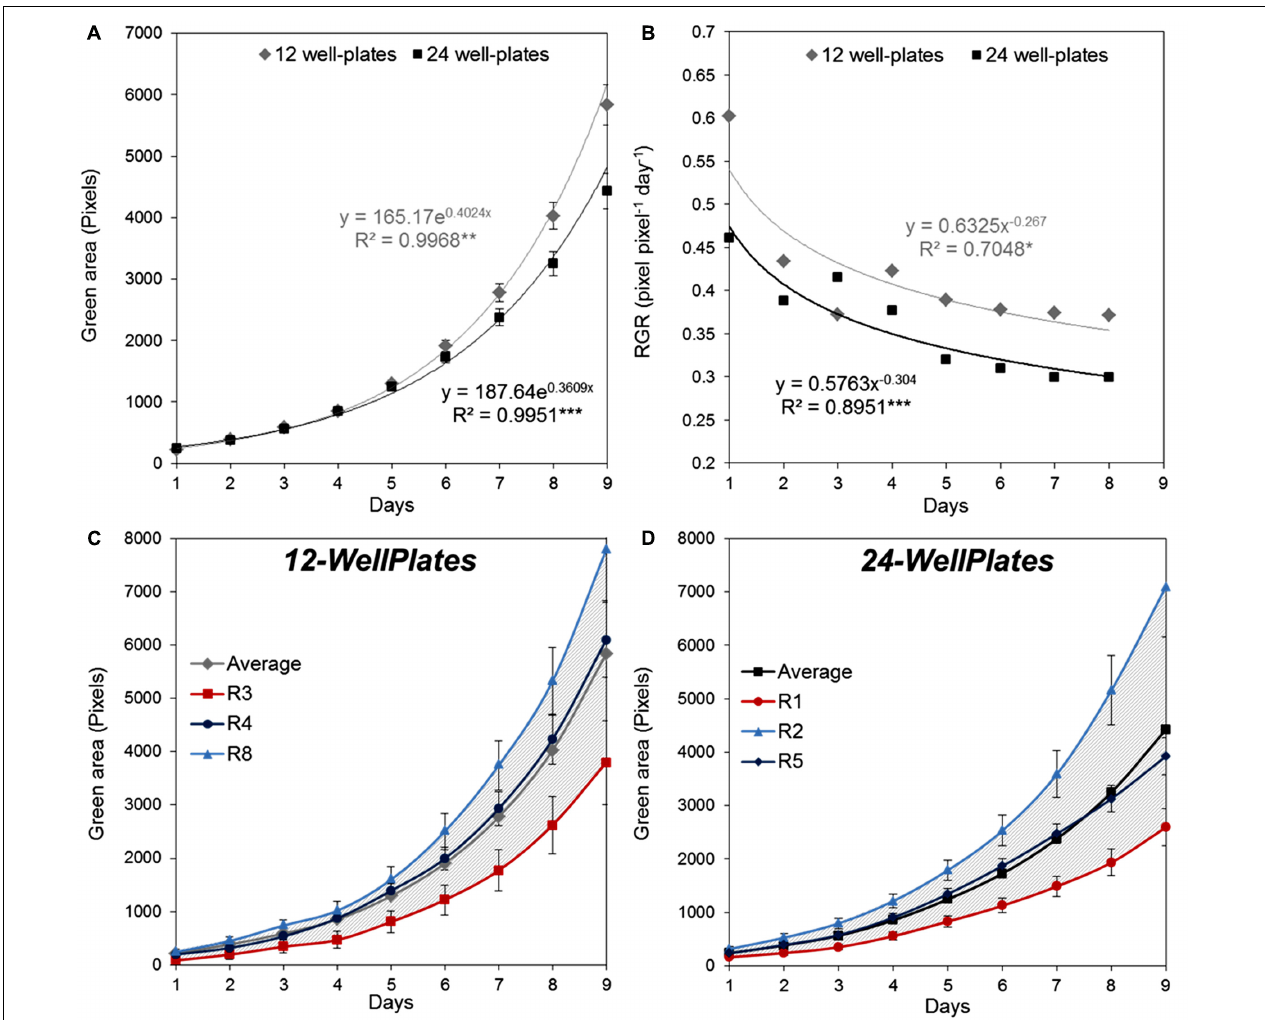
FIGURE 3 | Natural variation in Arabidopsis rosette growth in multi-well plates under control conditions. (A) Green area (pixels) of 4 DAG Arabidopsis seedlings grown in 12-well plates ( n = 108) or 24-well plates ( n = 144) with 1 × MS medium for 9 days. Mean ± SE (B) Relative growth ratio (RGR, pixel pixel − 1 day − 1 ) of 4 DAG Arabidopsis seedlings. The equations of the curves and the Pearson’s correlation coefficients with significance according to ANOVA after linearization were calculated. ∗ p < 0.05; ∗∗ p < 0.01; ∗∗∗ p < 0.001. (C) Green area (pixels) of 4 DAG Arabidopsis seedlings’ growth in independent 12-well plates (replicates). (D) Green area (pixels) of 4 DAG Arabidopsis seedlings’ growth in independent 24-well plates (replicates). Gray striped area represents the variation between replicates compared to the average treatment